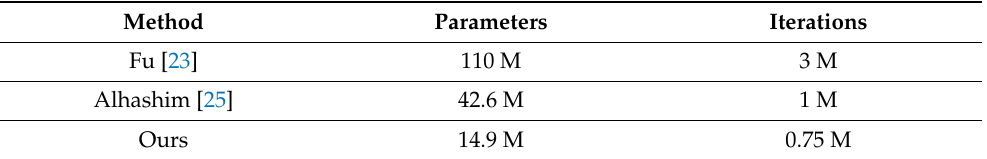
Figure 7. Visual effect comparison of the proposed method with transfer learning methods. ( a ) RGB images; ( b ) ground truth; ( c ) Fu’s method; ( d ) Alhashim’s method; ( e ) proposed method. Table 2. Comparison of parameters and iterations between the proposed method and transfer learning methods.